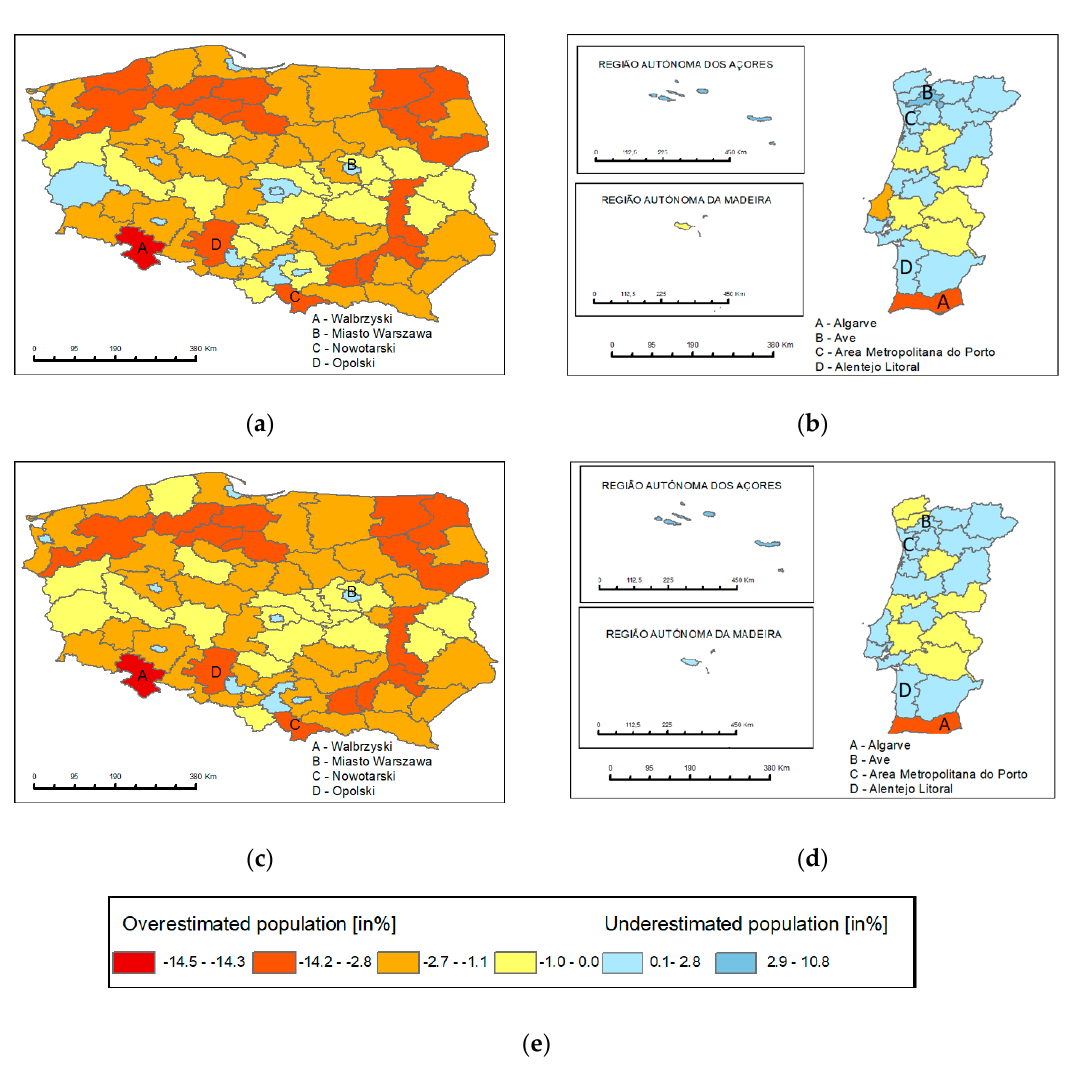
Figure 9. NUTS 3: MAPE. ( a ) GHS-POP 250 m, Poland; ( b ) GHS-POP 250 m, Portugal; ( c ) GHS-POP 1 km, Poland; ( d ) GHS-POP 1 km, Portugal; ( e ) legend.